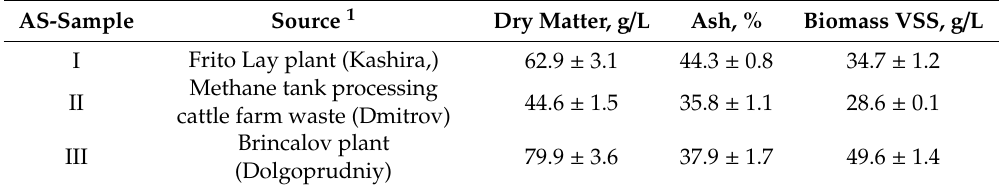
Table 4. Characteristics of the di ff erent AS samples used in this study. VSS: volatile suspended solids. AS-Sample Source